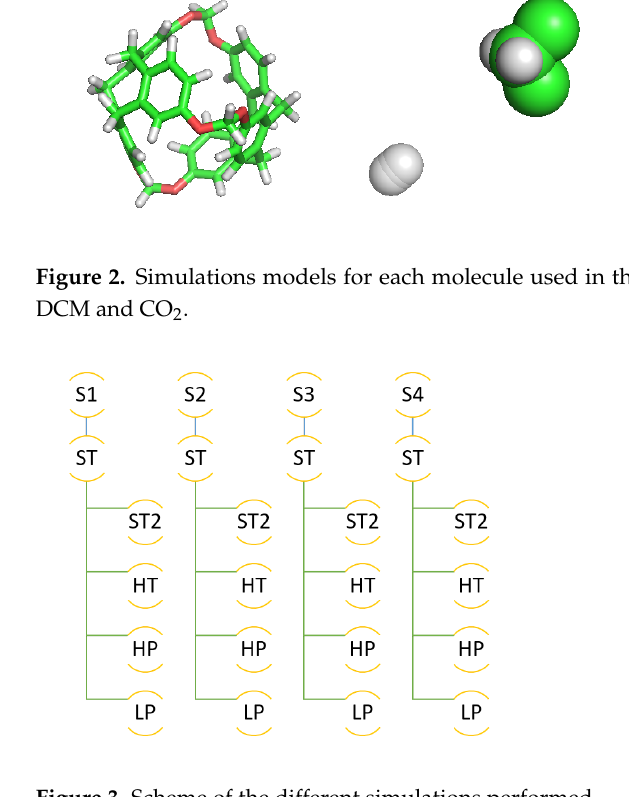
Figure 3. Scheme of the different simulations